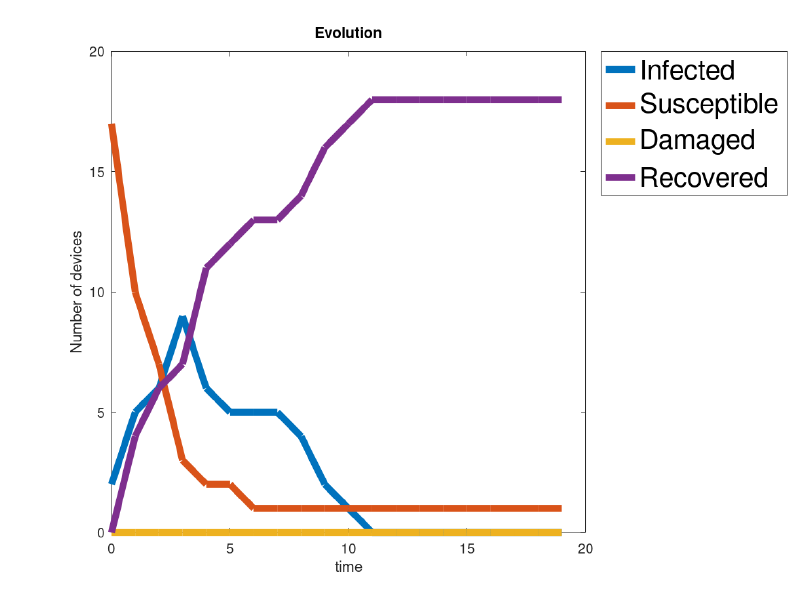
Figure 6. Malware propagation without damaged devices.